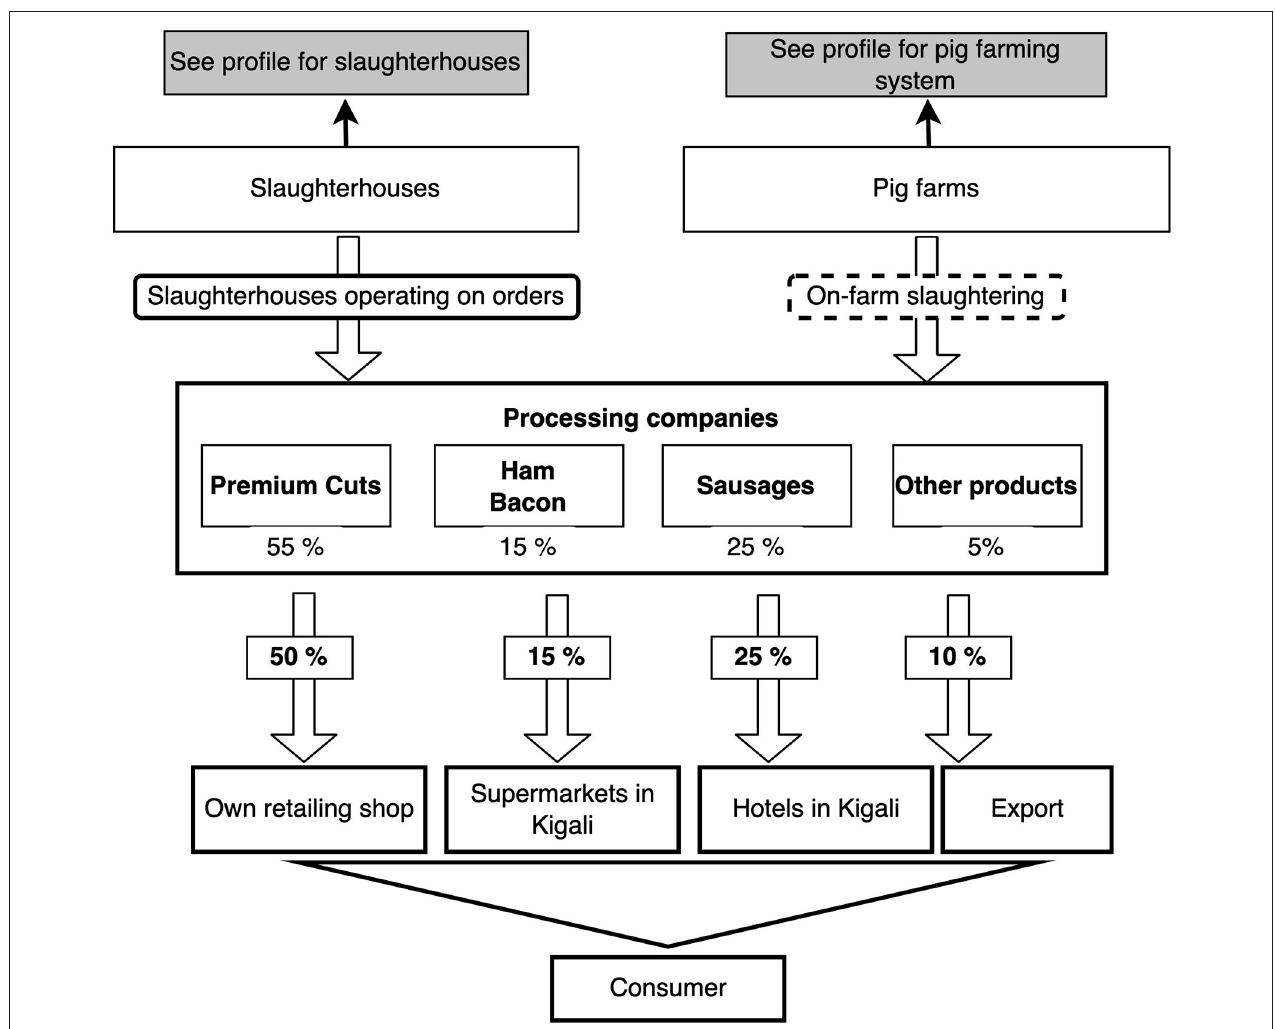
FIGURE 6 | Pork processing company profile: the flowchart shows sources and retailing channels for pork products. Percentages under pork products relate to the ratio of products manufactured. Percentage at the retailing places relate to volume supplied to each